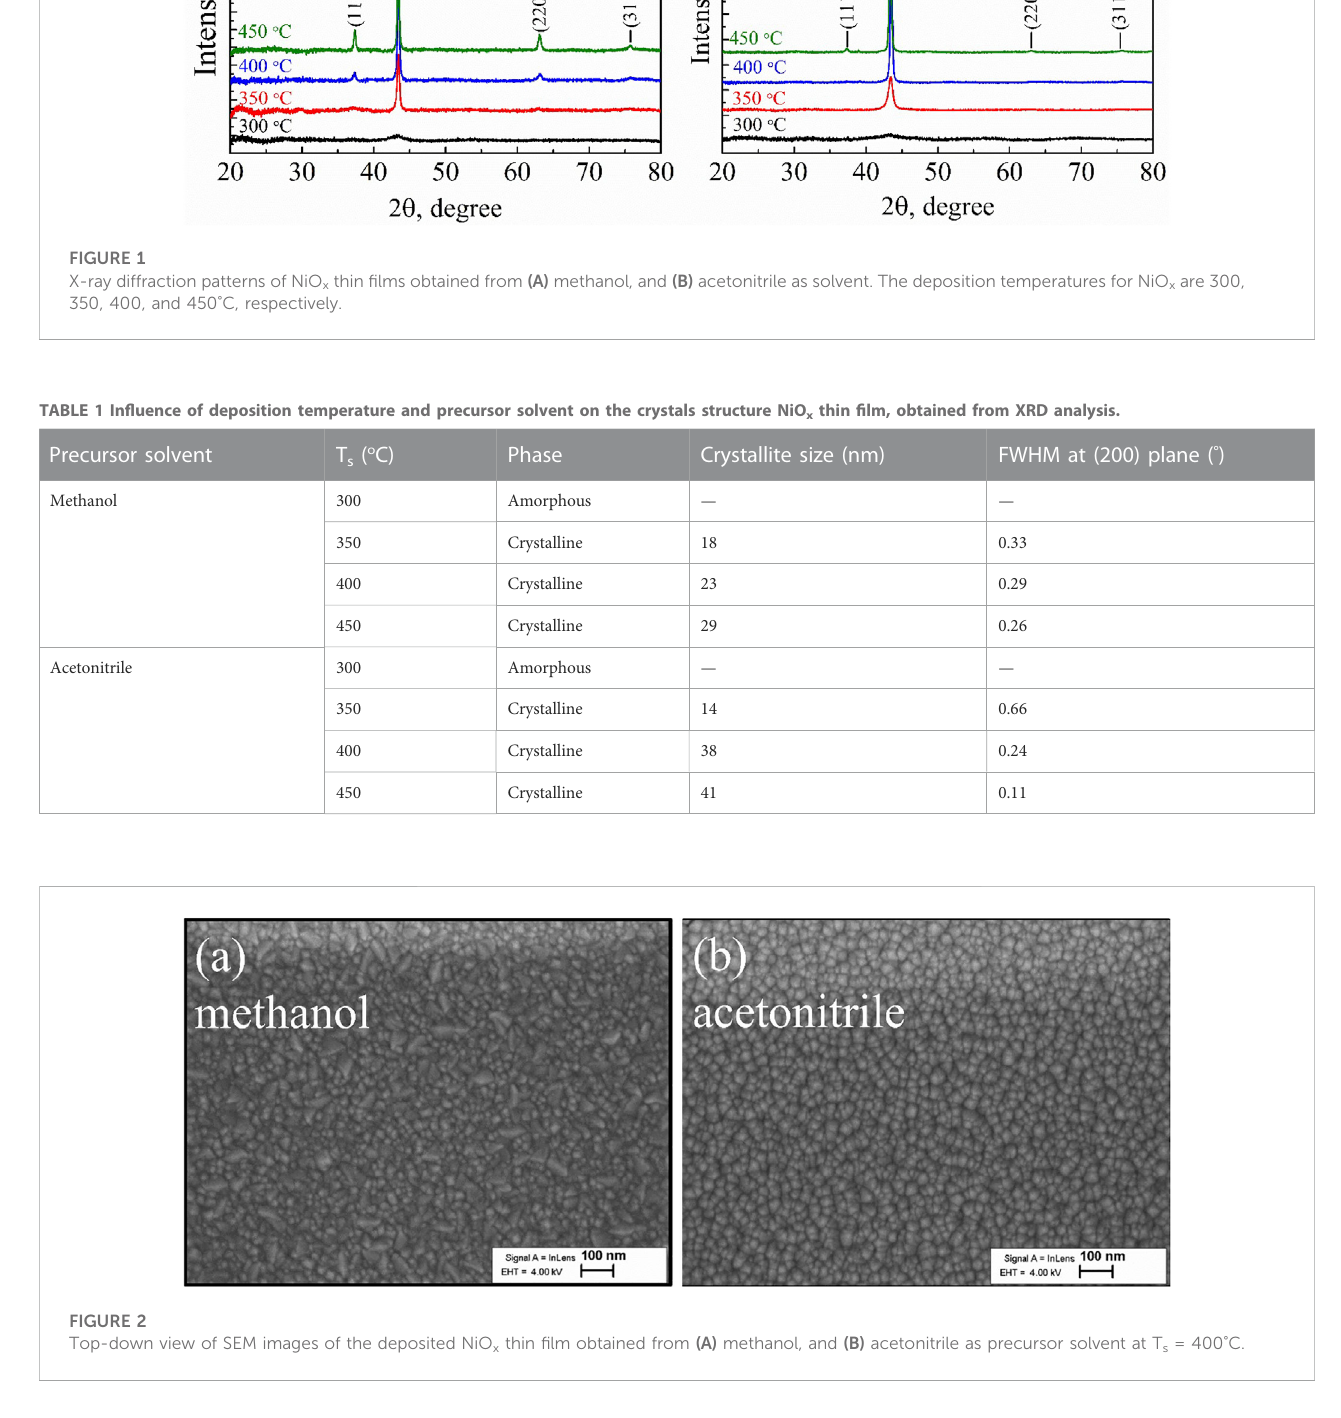
Figure 3A. Both fi lms demonstrated a high optical transmittance